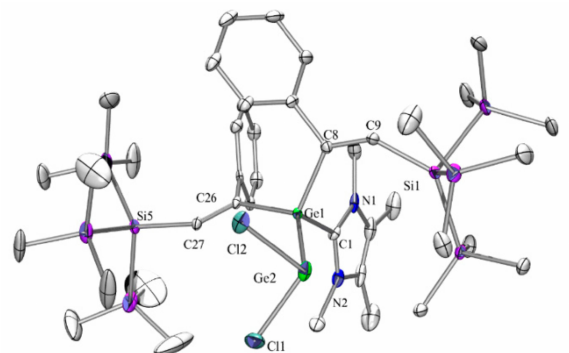
Figure 5. Molecular structure of 10 (thermal ellipsoid plot drawn at the 30% probability level). All hydrogen atoms and one molecule of THF in the asymmetric unit omitted for clarity (bond lengths in Å, angles in deg). Ge(1)–C(26) 1.995(4), Ge(1)–C(8) 1.999(4), Ge(1)–C(1) 2.006(4), Ge(1)–Ge(2)